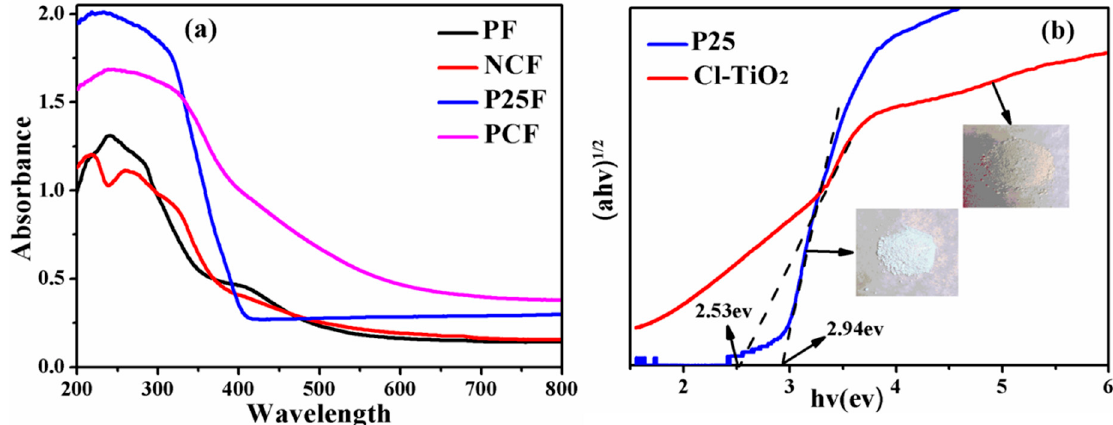
Figure 5. ( a ) UV-reflection spectra for pure fabric, P25-coated fabric, neoprene-coated fabric, and photocatalyst-coated fabrics. ( b ) Band baps for Cl-TiO 2 and P25 based on diffuse reflectance spectra.